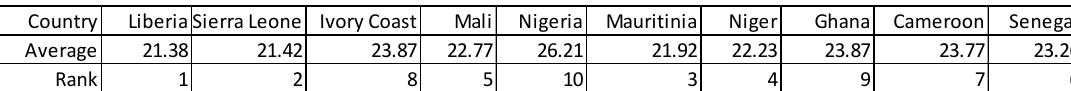
Figure A5. Market size Log of Real Gross Domestic Product (RGDP).